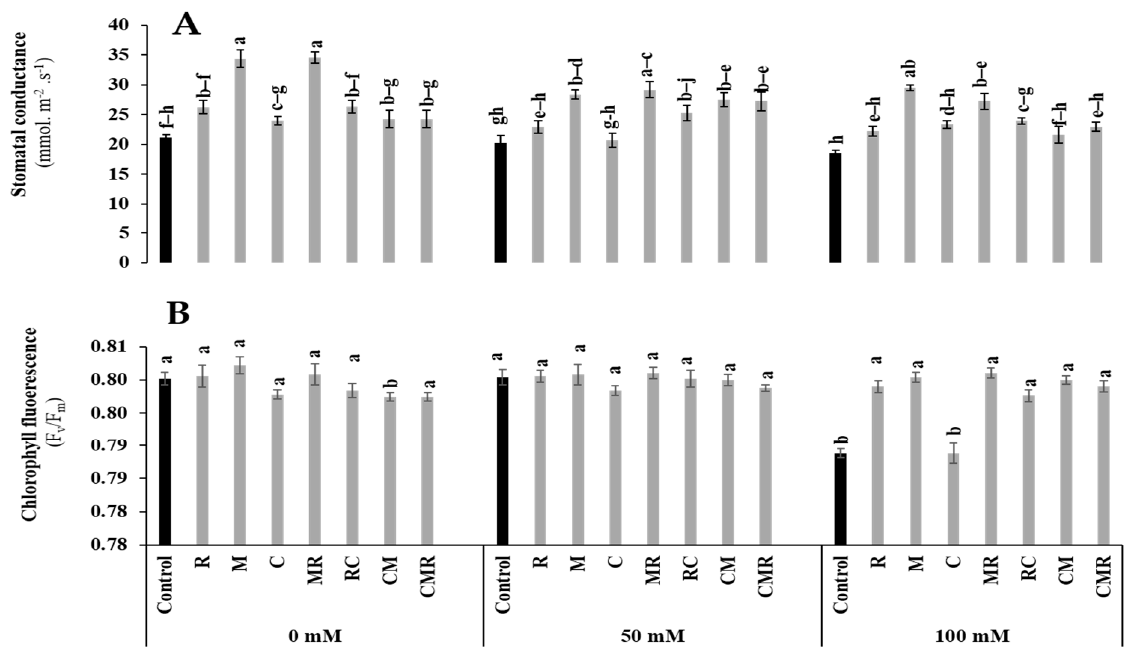
Figure 4. Impact of salt stress (0, 50, and 100 mM NaCl) on ( A ) Stomatal conductance and ( B ) chlorophyll fluorescence in lettuce subjected to different biostimulant treatments; control plants (non–amended, non–inoculated), and plants inoculated with plant growth promoting rhizobacteria (R) and/or arbuscular mycorrhizal fungi (M), and/or amended with composts (C). Means (±SE; 5 biological replicates) followed by the same letters are not significantly different at p < 0.05 (Tukey’s HSD).